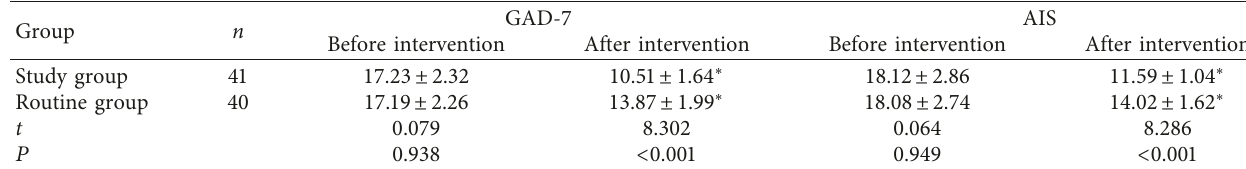
Table 3: Comparison of GAD-7 and AIS scores between the two groups ( x ± s , points). Group n